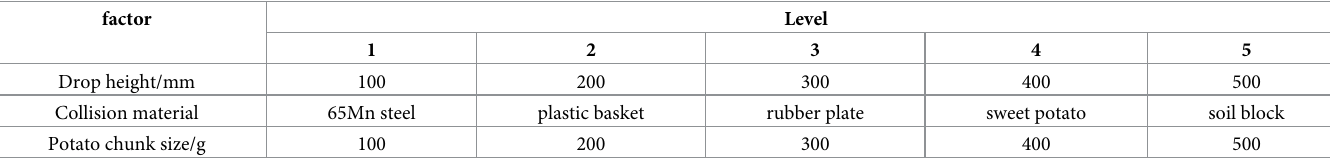
The table lists five levels of parameter setting for the three factors in the